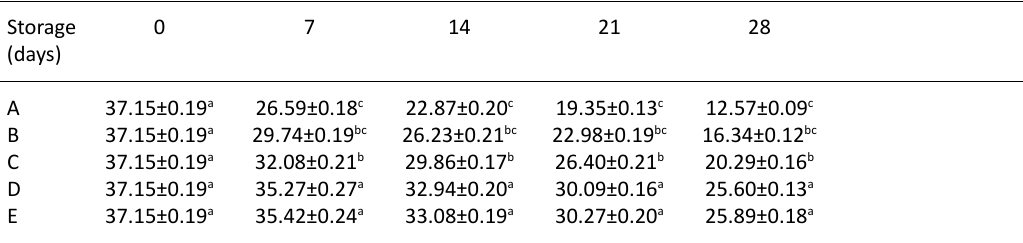
Table 3. Vitamin C content (mg/100 g) of mango fruit pre-coated by different MC-Car solutions during storage